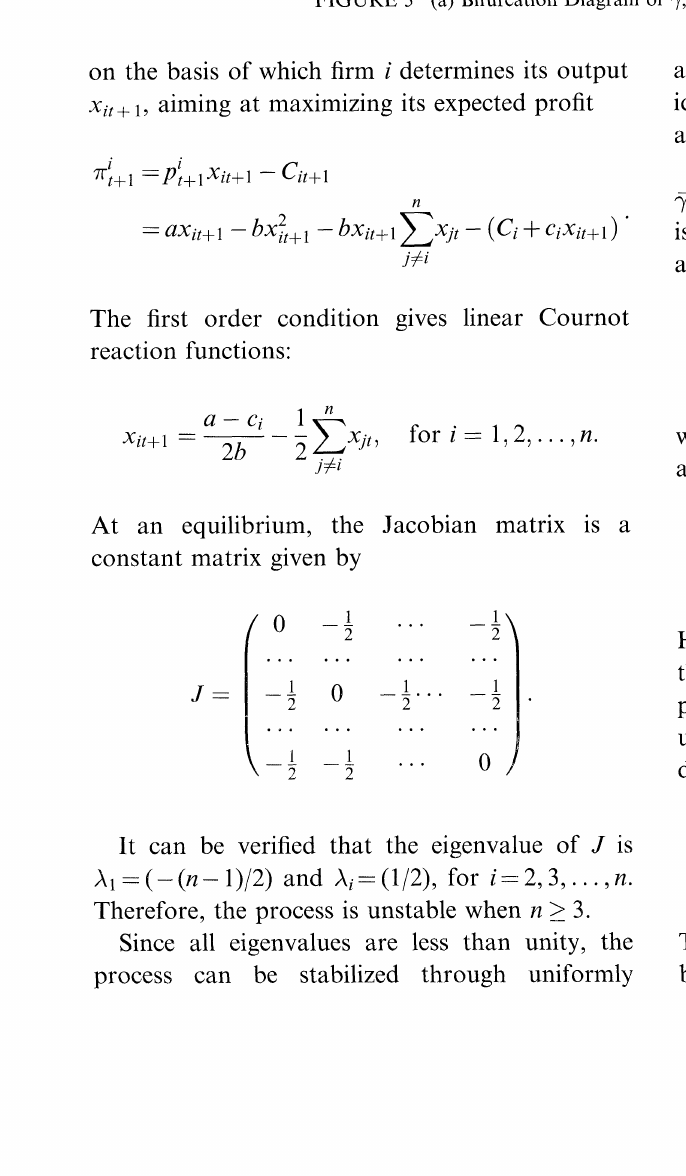
FIGURE 5 (a) Bifurcation Diagram of ; (b) Stabilized Orbits under